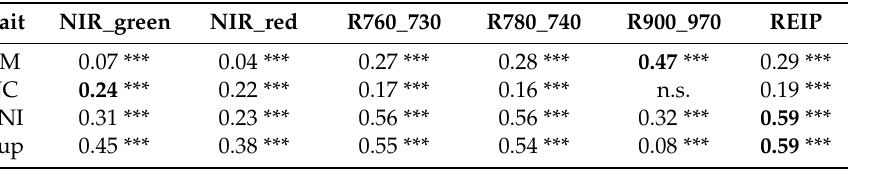
Table 4. Coe ffi cients of determination (R 2 ) with significance levels (***: p < 0.001; n.s.: p > 0.05) calculated across the total data range from all dates, with non-negative slopes (Figure 2: orange curve). Values of best indices per trait are marked in bold.